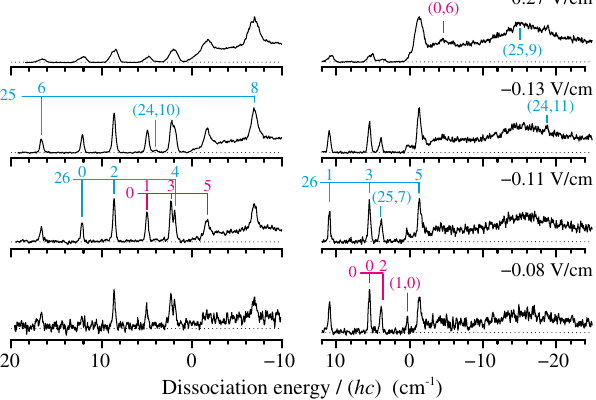
FIG. 3. PFI-ZEKE photoelectron spectra of ortho-D 2 (left) and para-D 2 (right) in the vicinity of the DI threshold. The spectra ¯ H were recorded from the ð 12 ; 4 Þ and (12,5) intermediate levels, respectively, with the electric field steps 3 ( − 80 mV = cm), 5 ( − 110 mV = cm), 6 ( − 130 mV = cm), and 8 ( − 270 mV = cm) of the pulse sequence described in Sec. II (from bottom to top). The energy scale was corrected for the field-induced shift of the ionization thresholds. See text for details.